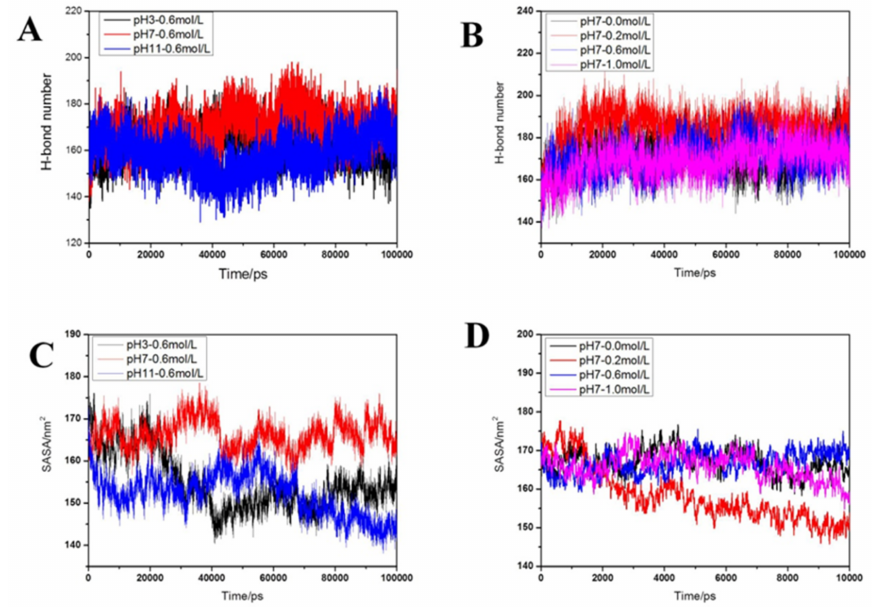
Figure 4. The H-bond number and SASA index changes under simulated system conditions: ( A ) H- bond number change under various pH; ( B ) H-bond number change under various NaCl concentra- tions; ( C ) SASA change under various pH; and ( D ) SASA change under various NaCl concentrations.